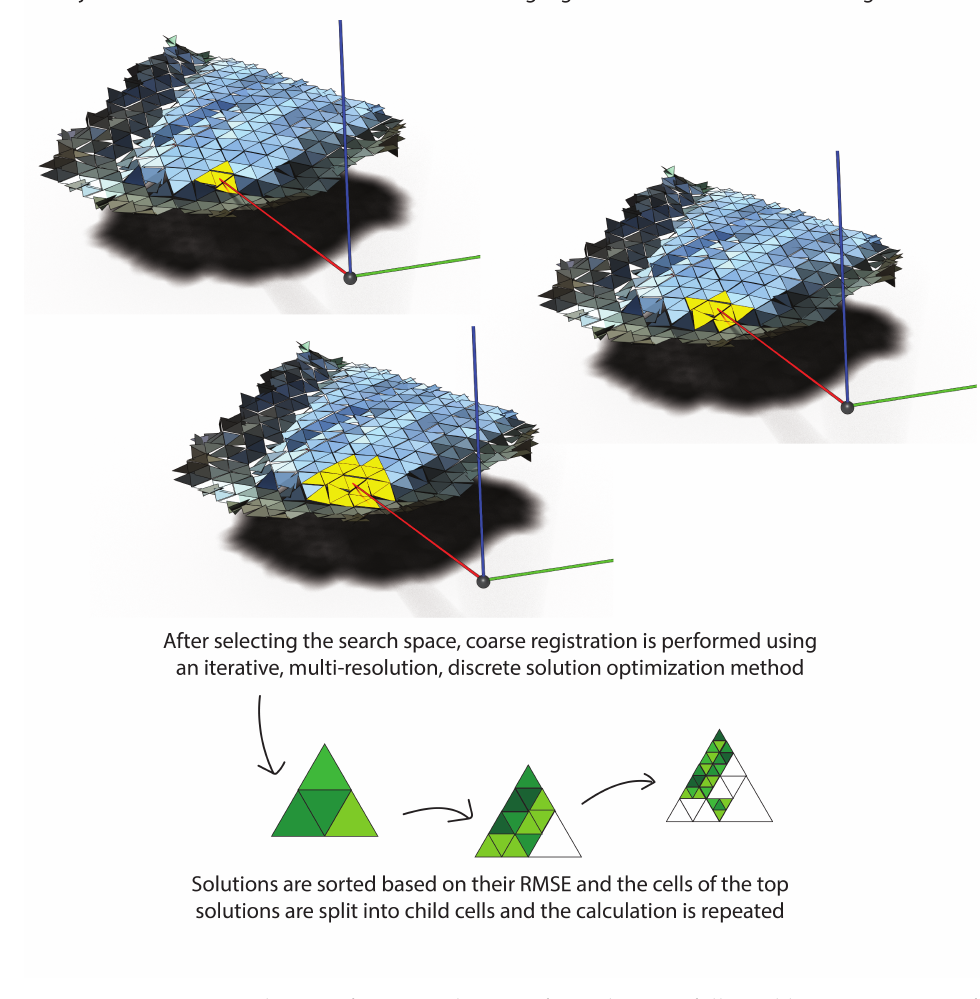
Figure 3. Process visualization for user selection of search space followed by optimization of fit. The reference frame of the UPC is indicated with the red-green-blue axes. The look-at-ray points along the red